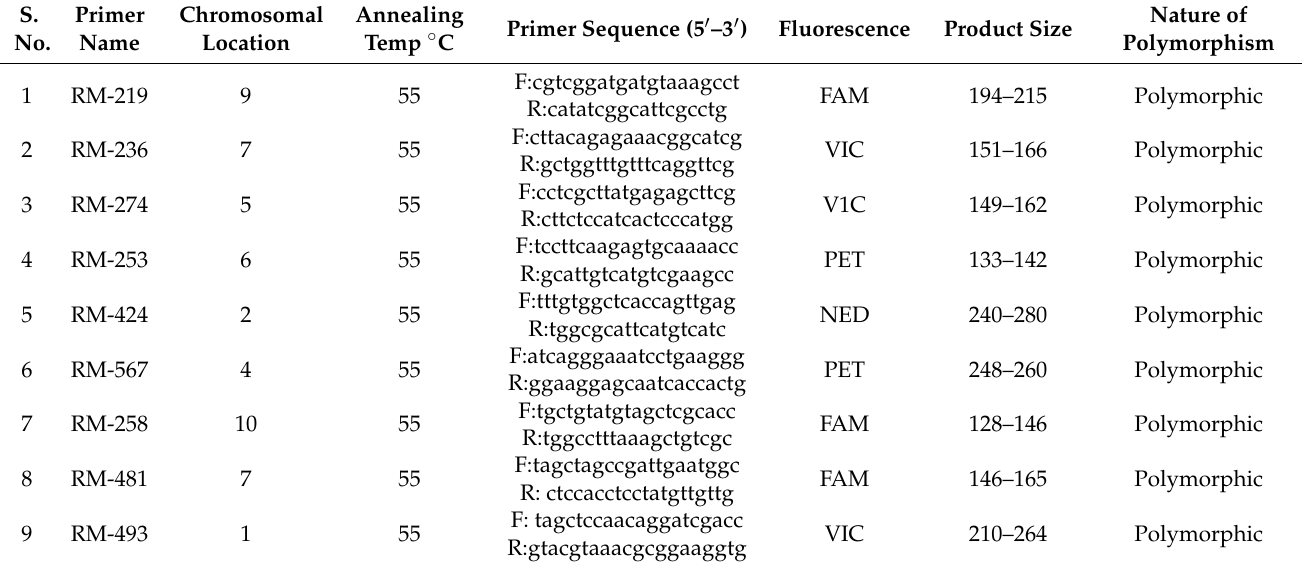
Table 1. SSR markers showed variability among rice hybrids based on various genotypic